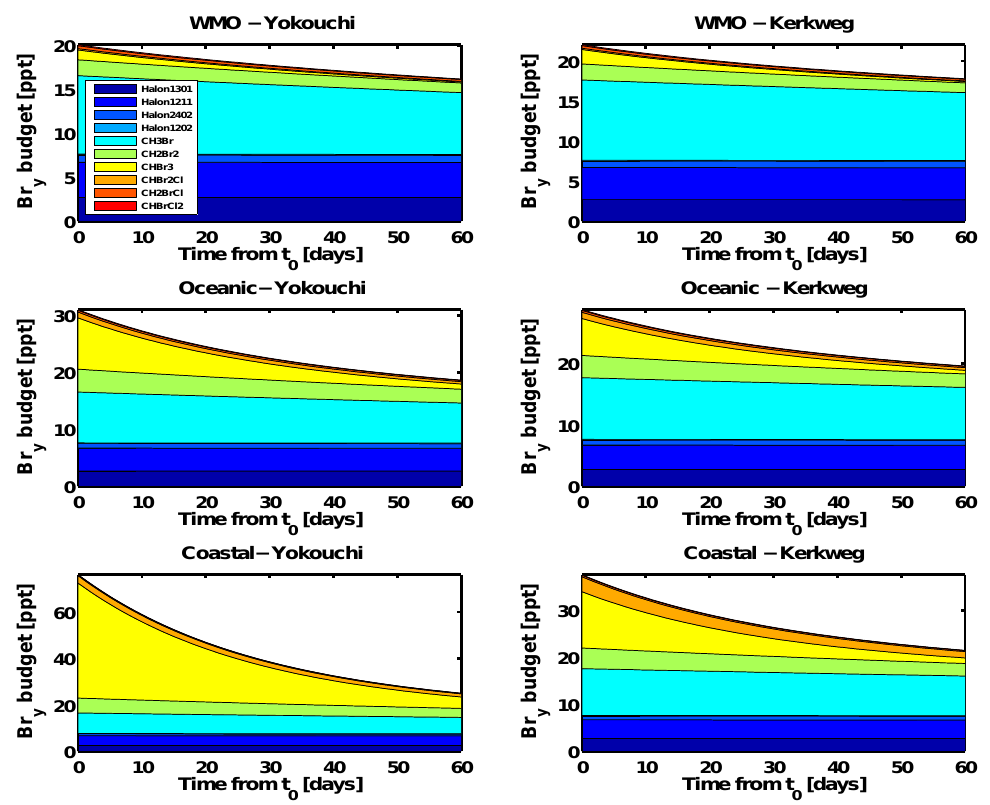
Fig. 2. The source gas contributions of bromine containing substances to the stratospheric Br y budget from t 0 (entrance time in the TTL). Both of the scenarios given in Table 2 are provided. The VSLS concentrations for the upper troposphere as provided in the WMO report (Law and Sturges, 2007) (upper left) and with the adjustment of CH 3 Br for the Kerkweg et al. (2008) scenario (upper right). The middle and lower panels give the oceanic and coastal concentrations for the VSLS respectively, for Yokouchi et al. (2005) (left) and Kerkweg et al. (2008) (right).